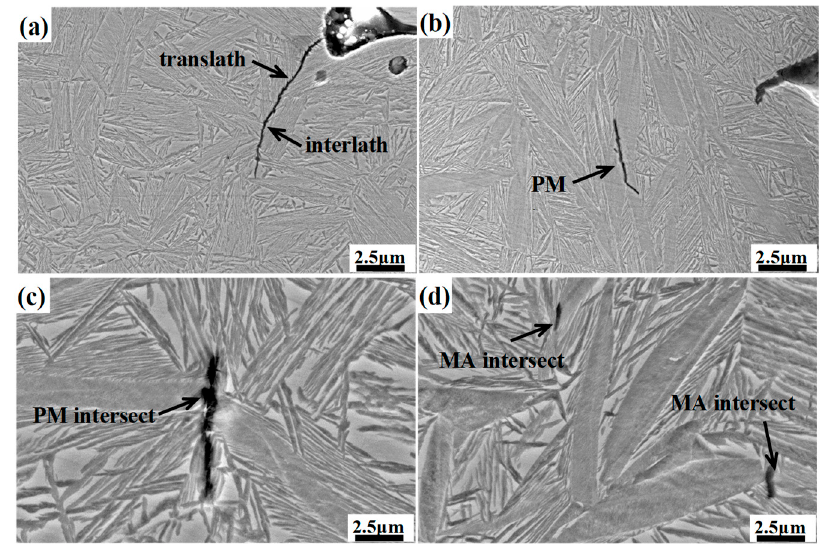
Figure 13. Micrograph of longitudinal section of different impact samples. ( a ) DIT sample; ( b – d ) QBT sample.